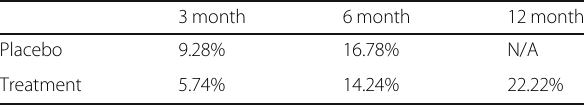
Table 3 Time dependent discontinue rate in treatment group compared with placebo 3 month 6 month 12 month Placebo 9.28% 16.78% N/A Treatment 5.74% 14.24% 22.22% N/A Not